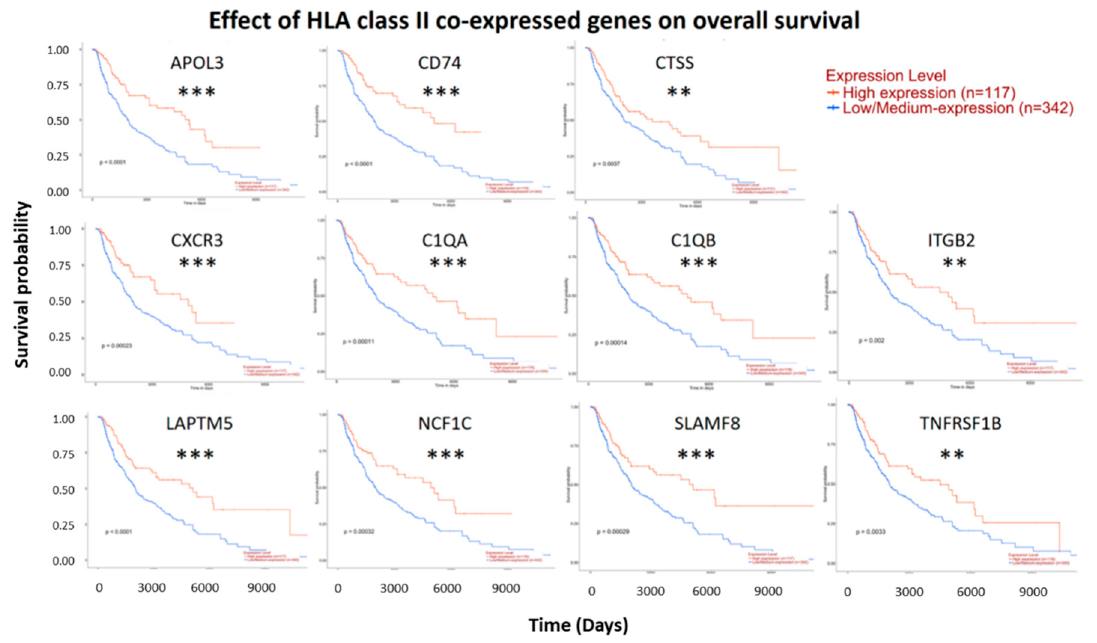
Figure 8. Effect of HLA class II co-expressed genes on overall survival. Survival analysis of HLA-DPA1 and/or HLA-DRA co-expressed genes in cutaneous melanoma was performed by the UALCAN database. Patients with high expression group showed better overall survival. ** Indicates p value < 0.01, *** indicates p value < 0.001. Table 7. Association of 11 HLA class II co-expressed genes in cutaneous melanoma with survival generated from Cox regression analysis via OncoLnc.